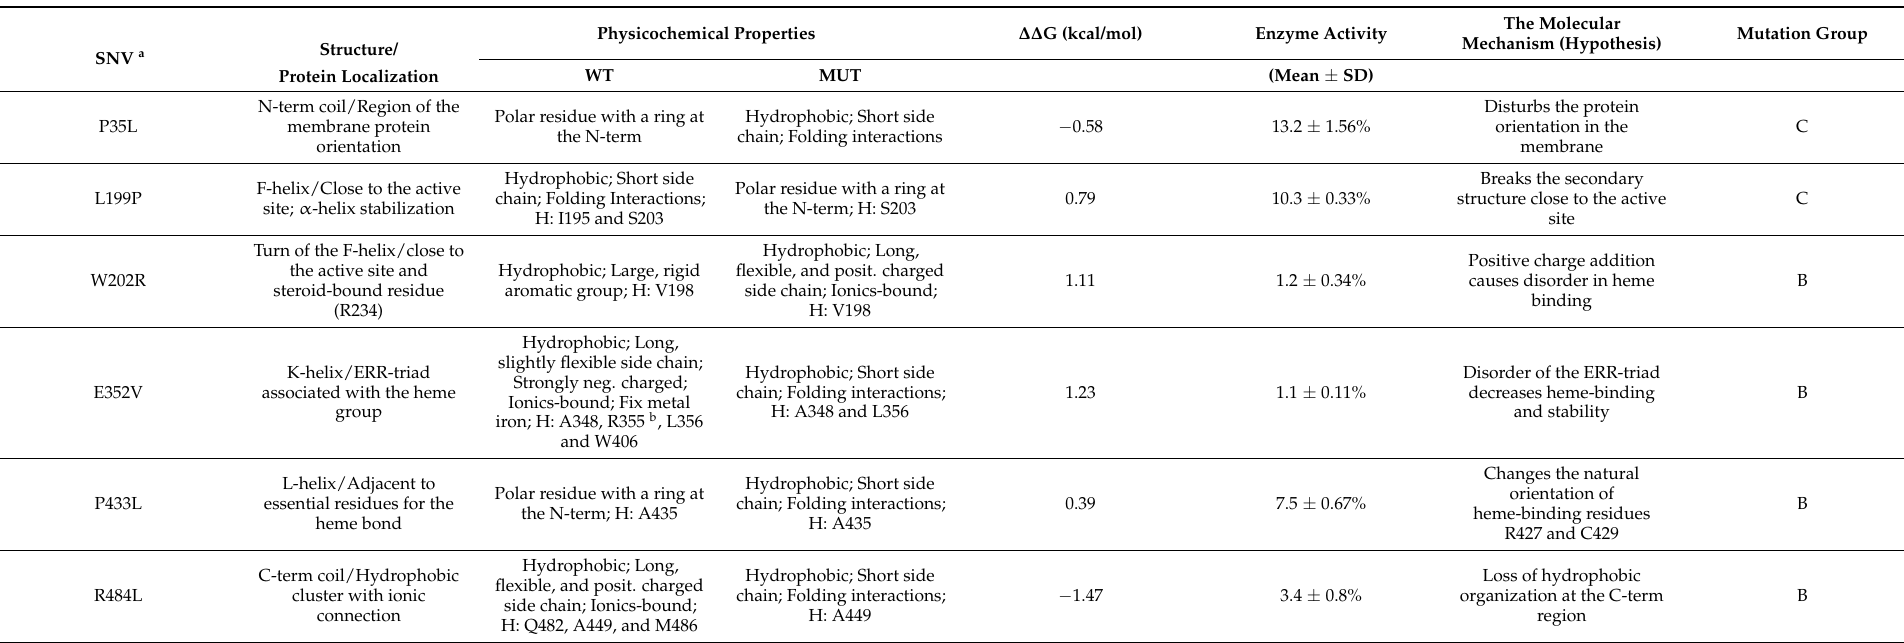
Table 3. Summary of structural and functional data obtained for the six variants studied shows that all of them can be related to CYP21A2deficiency. a